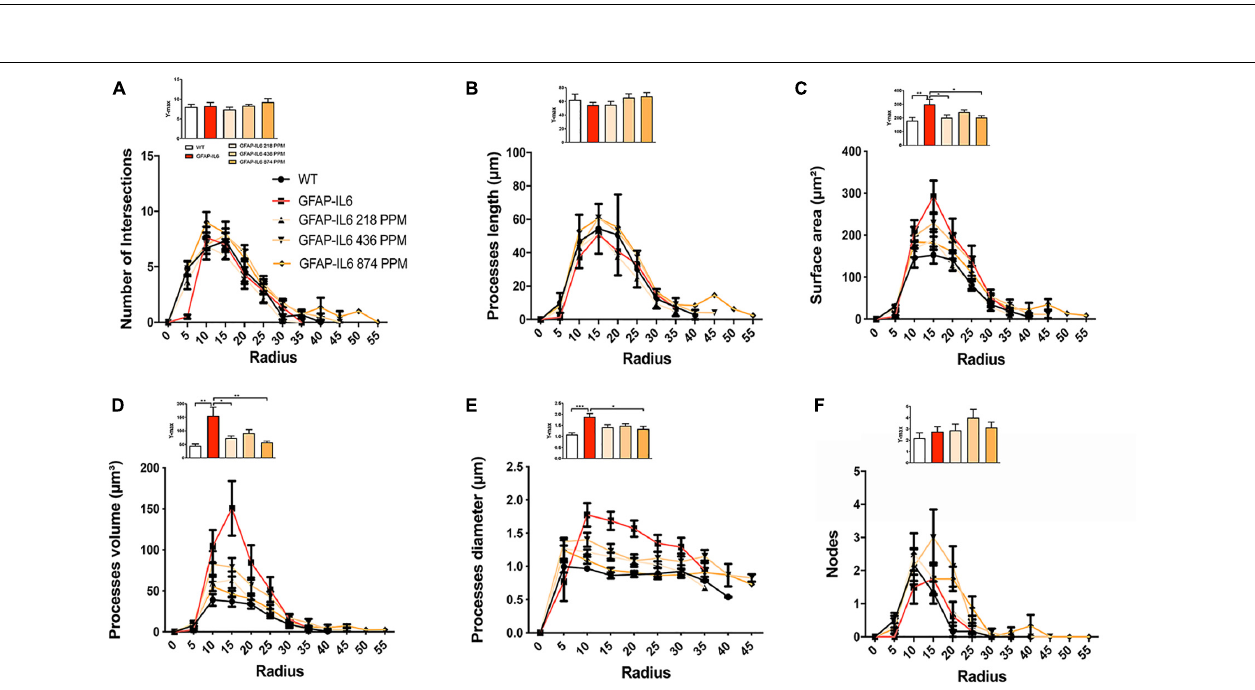
FIGURE 11 | MC retracted the size if microglial cells in the cerebellum. A Sholl analysis revealed a significant change in the surface area, processes volume and processes diameter of microglia between wild type and GFAP-IL6 inflamed microglia both in the cerebellum. (A–F) MC retracted surface area, processes volume and processes diameter compared to the inflamed microglia. This can be observed in the peaks of the distributions of different morphological features being closer to the center compared with the WT and GFAP-IL6 mice, we call it X at Ymax. One-way ANOVA test.